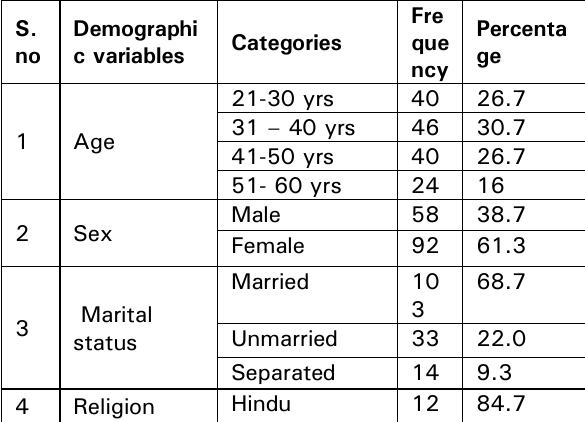
Table - 1: frequency and percentage